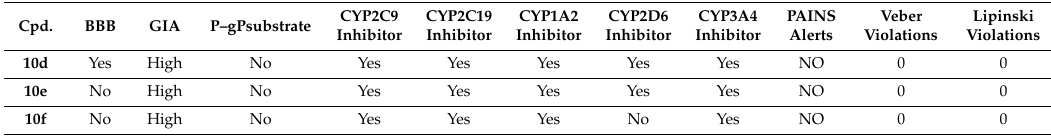
Table 7. In silico-predicted ADME and druglikeness properties of benzimidazole derivatives 10d – f .